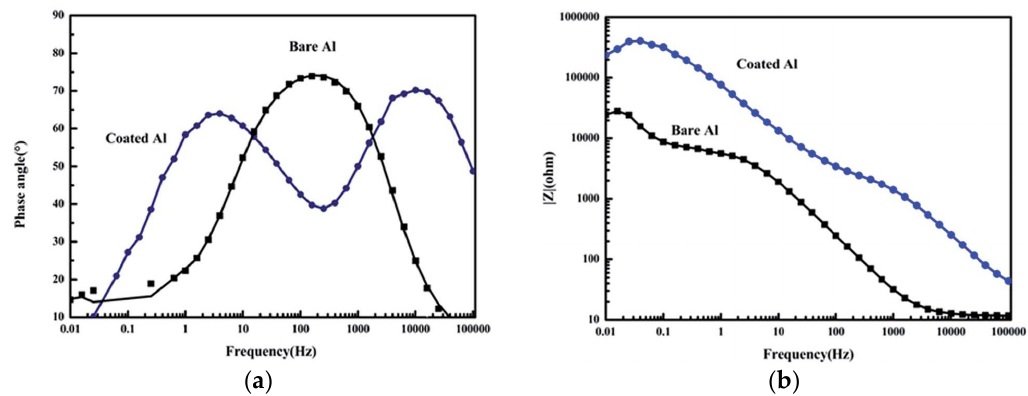
Figure 9. ( a ) Bode Phase angle diagrams and ( b ) Bode modulus diagrams of graphene coated Al alloy and bare Al alloy. Reprinted from [105] with permission; Copyright Royal Society of Chemistry 2014.